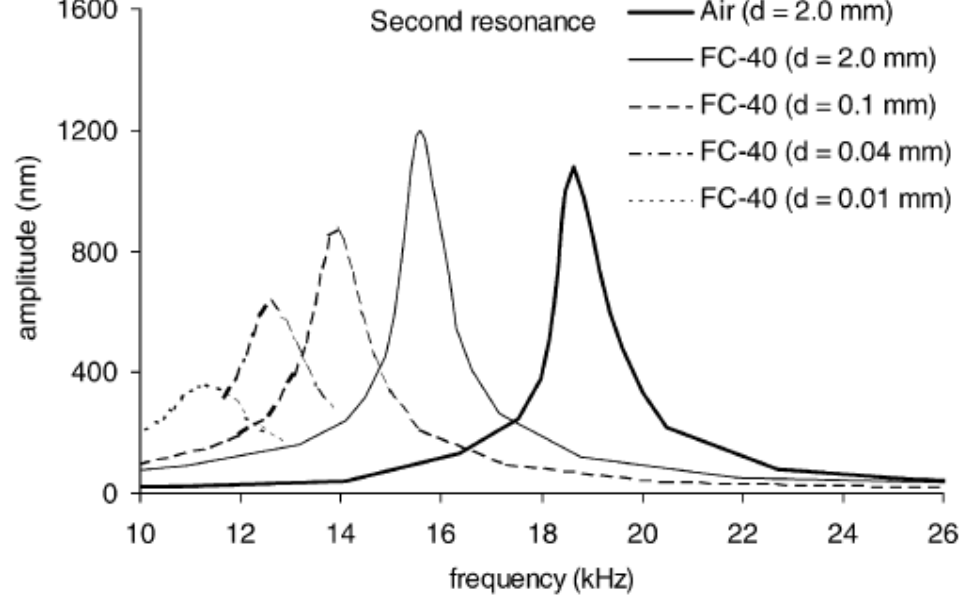
Figure 8. Influence of the cantilever–surface position on the resonant frequency [92].